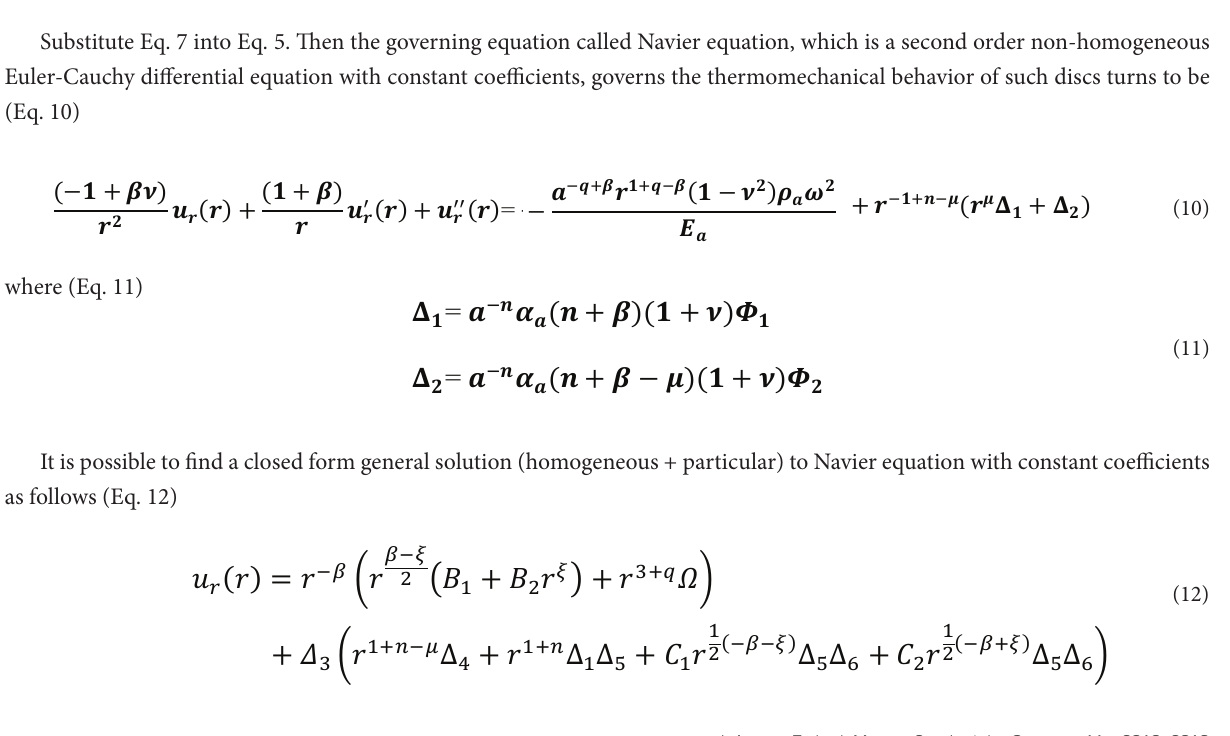
Let’s choose a simple power law grading rule with inhomogeneity indexes by β, q , and n (Eq.